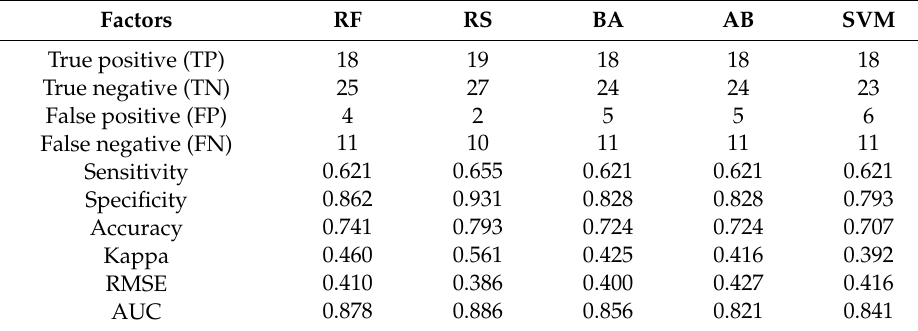
Table 3. Evaluation and comparison of models by validation